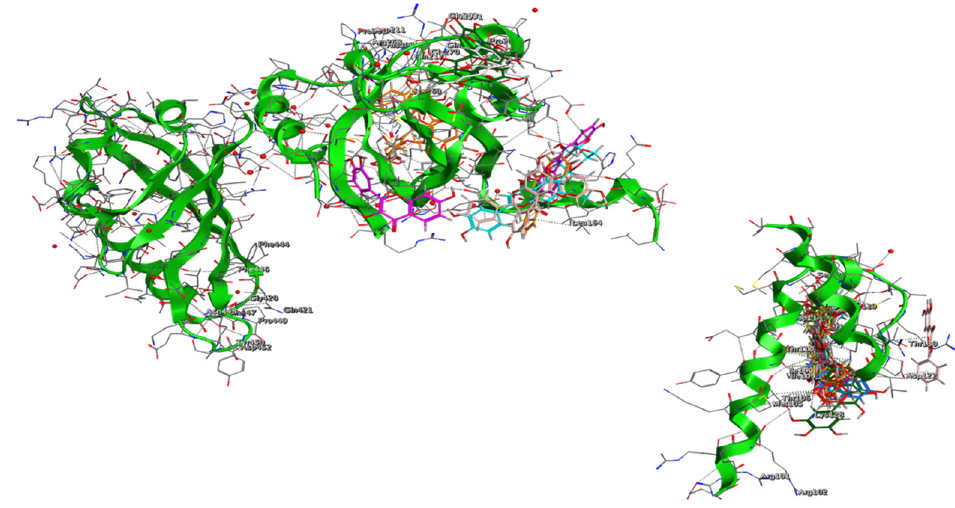
Figure 4. Interaction of flavonoids at the interface of the bHLH and PAS-A domains of ARNT.